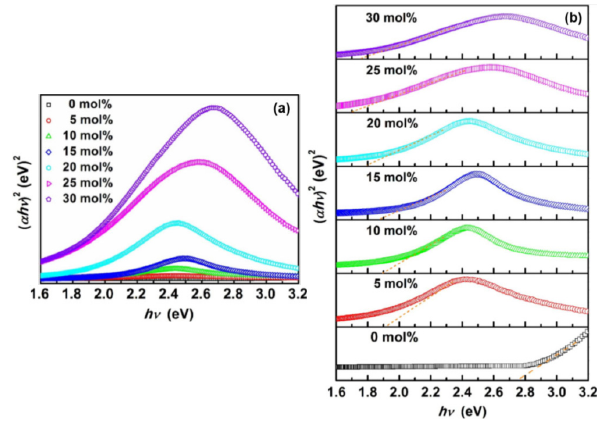
Fig. 6 Relationship between 2 ( ) h  and h  for the Ag x /BTO thin